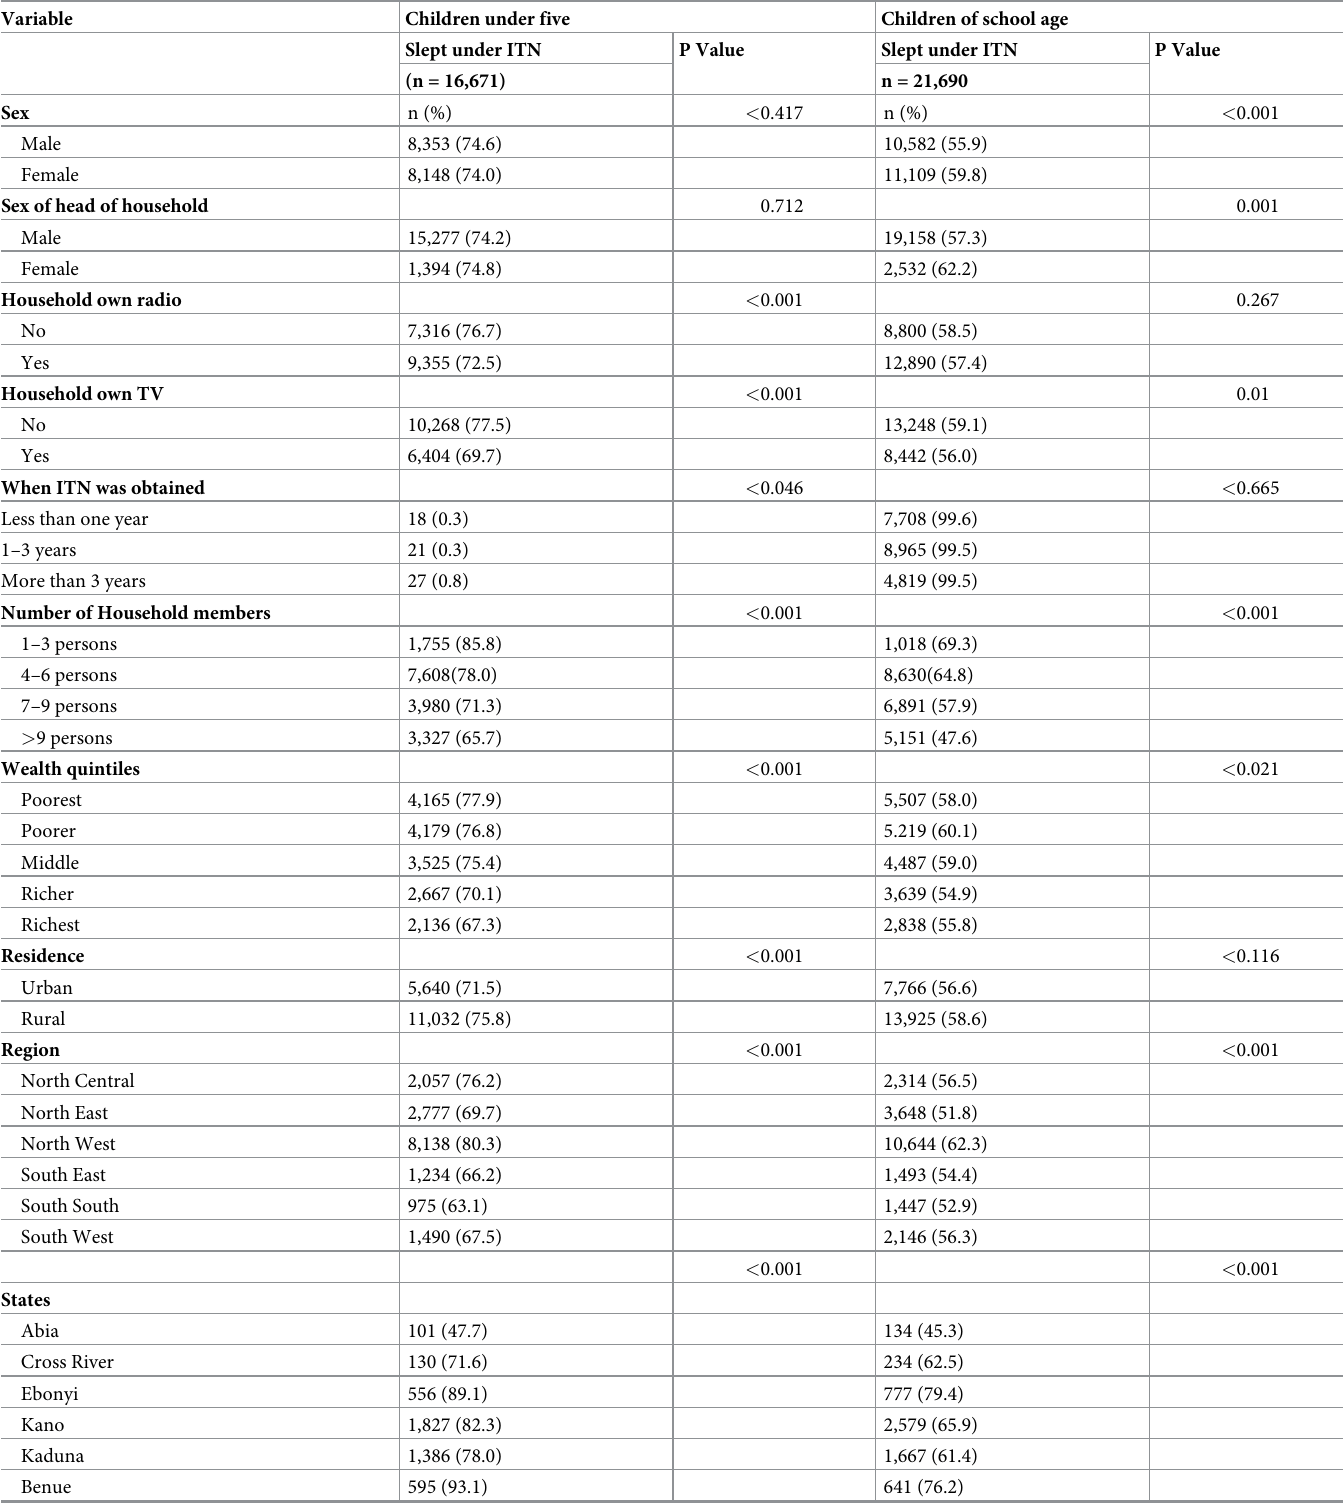
Table 2. Use of ITN in CU5 and children of school age living in households with at least one ITN by demographic characteristics.